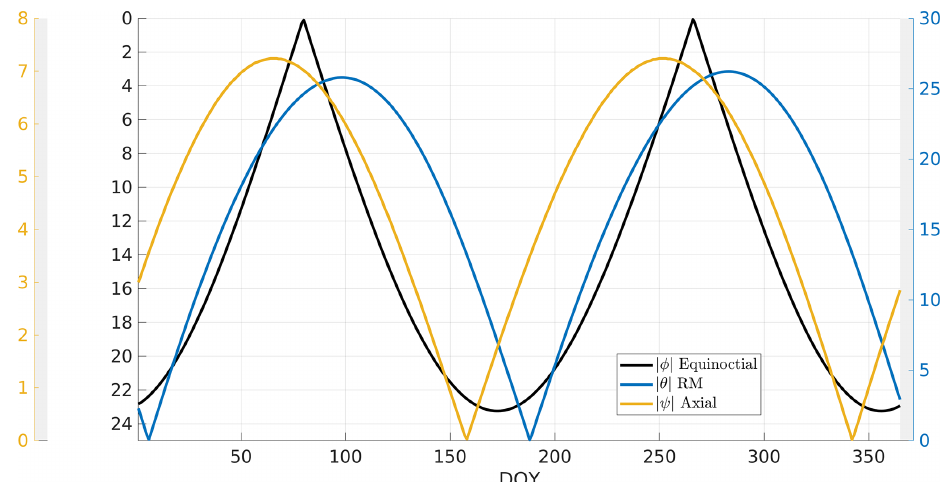
Figure 8. Absolute value of the angles that might control the SAV. φ , θ and ψ are associated to the equinoctial, RM and axial hypotheses, respectively.